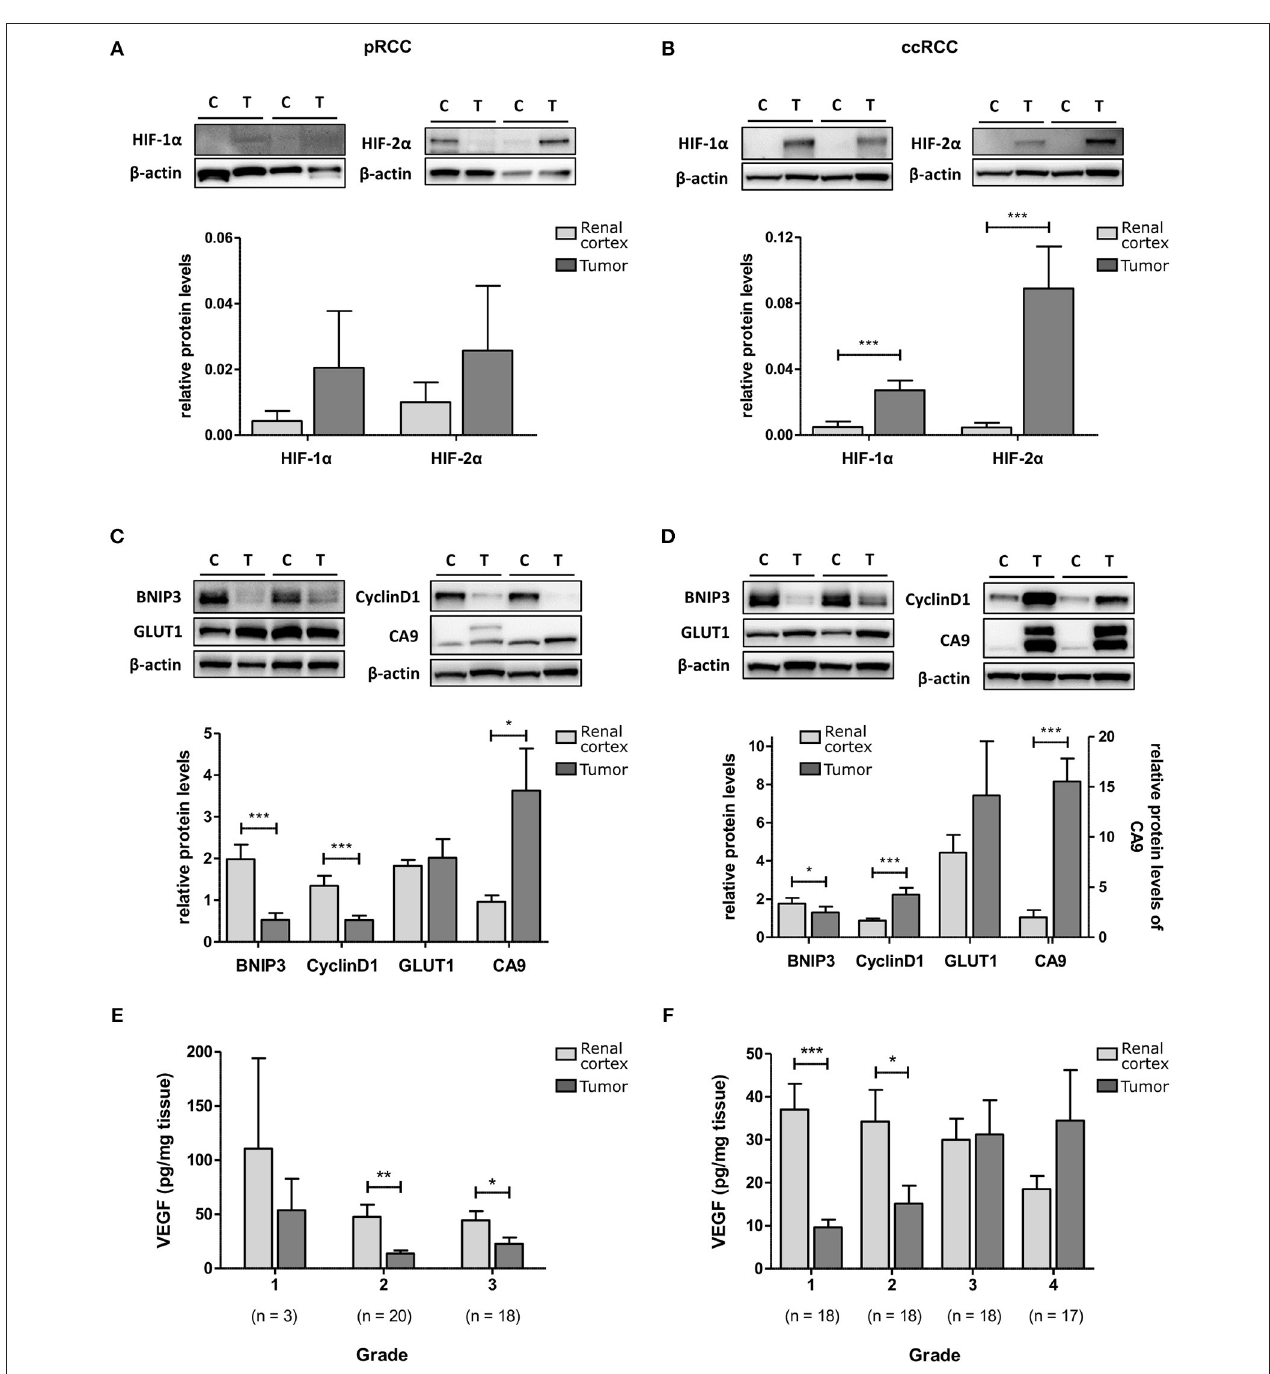
FIGURE 2 | HIF-1 and HIF-2 activation in pRCC and ccRCC samples compared to renal cortex tissue. Representative Western Blots for renal cortex (C) and tumor (T) tissue for pRCC ( n = 41, left panel) and ccRCC ( n = 73, right panel) are shown for HIF-1 α and HIF-2 α (A,B), and their downstream targets BNIP3, cyclin D1, Glut-1 and CA9 (C,D) . β -actin was used as a loading control. The example blots in (B) show the same blot probed sequentially after stripping of previous primary and secondary antibodies. Bar charts show the band density of the respective proteins referenced to a control sample (Hypoxia treated T24 cell lysate) which was loaded on each gel. VEGF content of RCC and cortex tissue samples, as measured by ELISA, is reduced in tumor tissue of all grades for pRCC (E) and low grade ccRCC (F) with tendency to be elevated in high grade ccRCC, compared to cortex tissue. Light gray, renal cortex tissue; dark gray, tumor tissue. Statistical significance was assessed with the Wilcoxon matched-pairs signed rank test. Data represent mean + SEM; * p < 0.05; ** p < 0.01; *** p < 0.001.